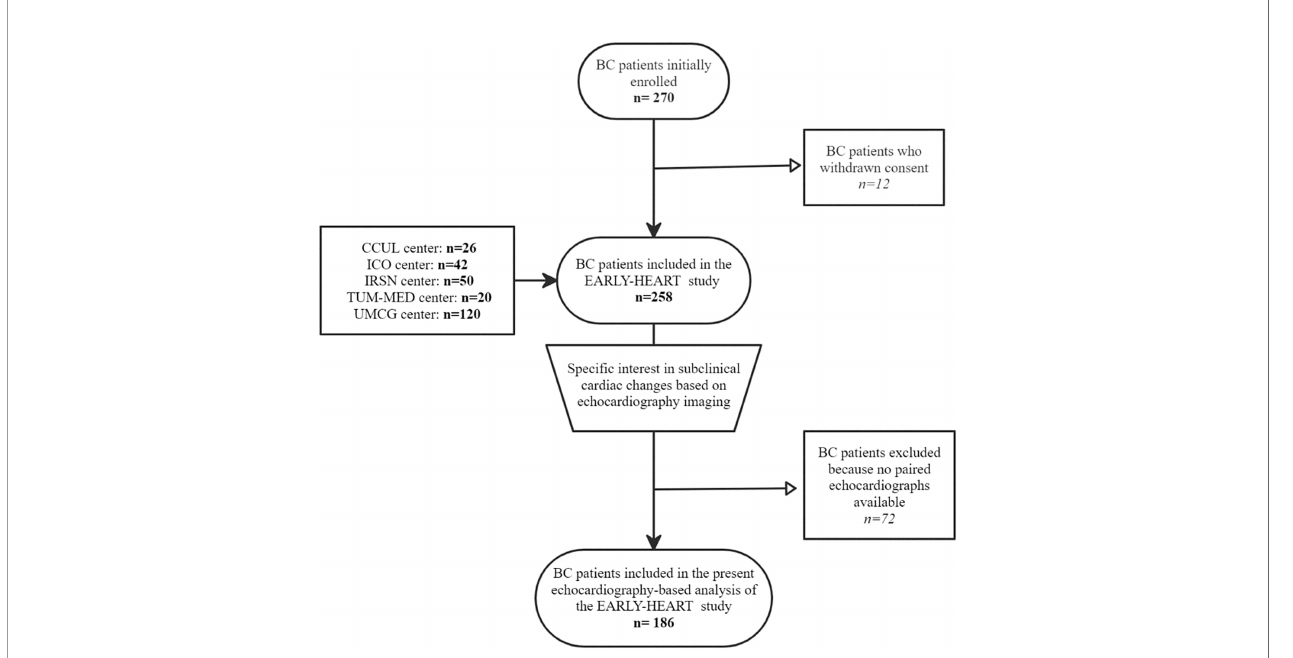
FIGURE 1 | Flowchart of BC patient inclusion and exclusion in the EARLY-HEART study based on